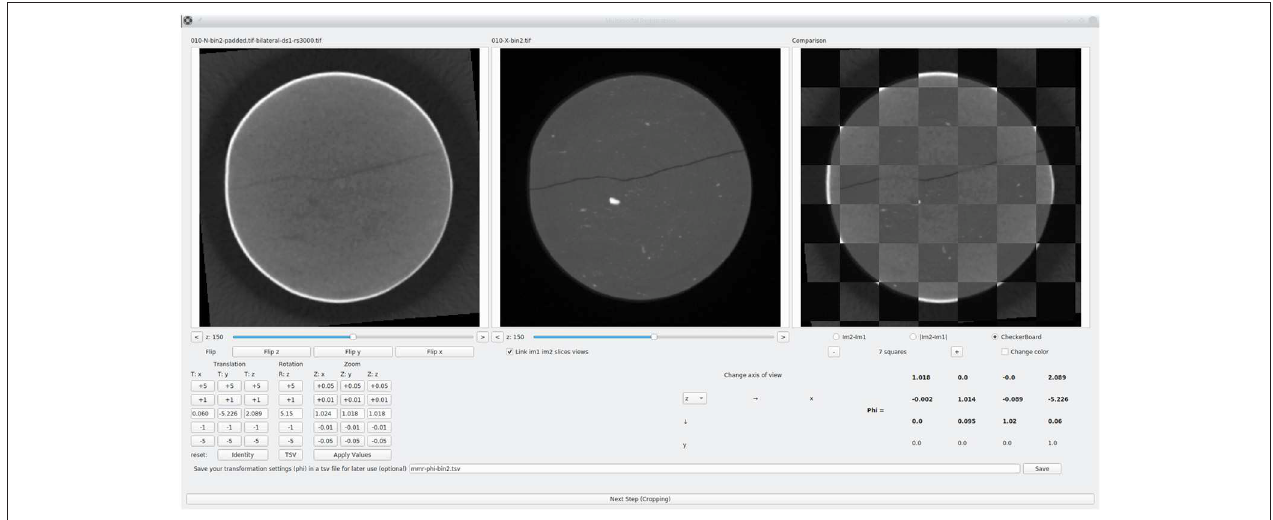
FIGURE 2 | Example of graphical tool (available in spam) developed in Qt allowing an accurate initial 8 to be manually applied to the neutrons to initialise the multimodal registration as close as possible to the correct solution. Top row: Horizontal slices through tomographies: (left) neutron (middle) x-rays (right) “checkerboard” allowing comparison. Bottom row: (left) Buttons to apply displacements, rotations and zooms to left image (middle) slice view settings (right) current 8 matrix. This software is free software and is included in the ‘‘spam” python package.